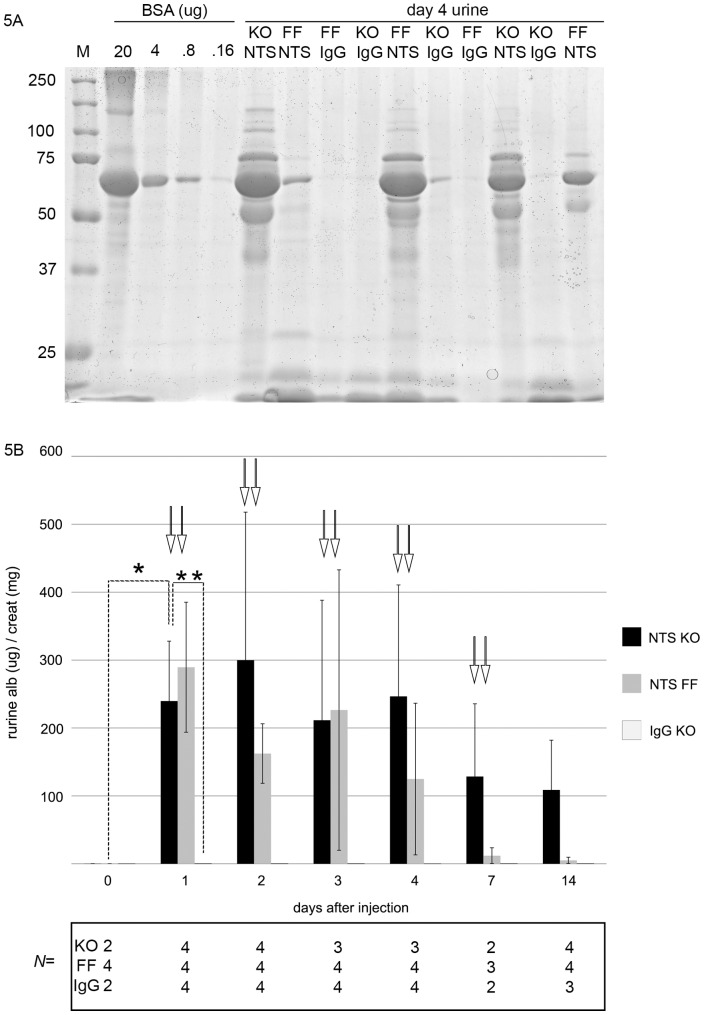
PodΔMyh9
 mice (KO) are not hypersensitive to acute glomerular injury from sheep nephrotoxic serum (NTS).
C57BL/6 mice between 12 and 24 weeks of age were tested for predisposition to glomerular injury after injection of either 2.5 mg of sheep NTS or 2.5 mg of control sheep IgG, each resuspended in sterile phosphate buffered saline. Urine was collected at t = 0 before injection, then at days 1, 2, 3, 4, 7, and 14 after injection. (A) SDS-PAGE with Coomassie stain of urine 4 days after injection to screen for albuminuria. M = marker (Precision Plus Dual Color, Bio-Rad); BSA = bovine serum albumin in ug/lane. Sample lanes of the indicated genotype contain 2.5 microliters of urine in sample buffer. (KO) = Podocin::Cre/+; Myh9flox/flox and (FF) = cre−; Myh9flox/flox. (B) Quantification of albuminuria normalized to urine concentration. Y axis is the ACR (ratio of albuminuria to urine creatinine), similar to Figures 1 and 3. Numbers of animals for each timepoint and each genotype are indicated below the abscissa. Data were analyzed by unpaired T-test with Welch correction. On one hand, as intended, KO mice had significantly more albuminuria after receiving NTS: (*) ACR on day1 after NTS was 239+/−44 ug/mg versus day 0 ACR of 0.2 ug/mg+/−0.0007, p = 0.01, and albuminuria after NTS injection persisted through day 14. Similarly (**), the ACR on day1 after NTS was 239+/−44 ug/mg versus 0.4+/−0.3 ug/mg on day 1 after control sheep IgG, p = .012). However, (↓↓) for each day after injection with NTS, there is no difference in the magnitude of albuminuria between KO and control mice: day 1 p = 0.58; day 2 p = 0.31; day 3 p = 0.20; day 4 p = 0.396; day 7 p = 0.37. At day 14, there is a trend towards a difference between KO and control mice injected with NTS, p = 0.06, but in addition to the low N, this late timepoint is confounded by the contribution of an Fc dependent response from the immune system.